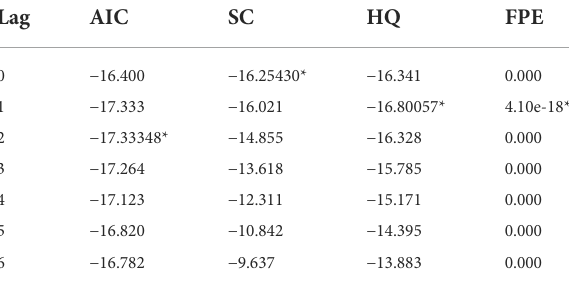
TABLE 3 Criterion of optimal lag order in